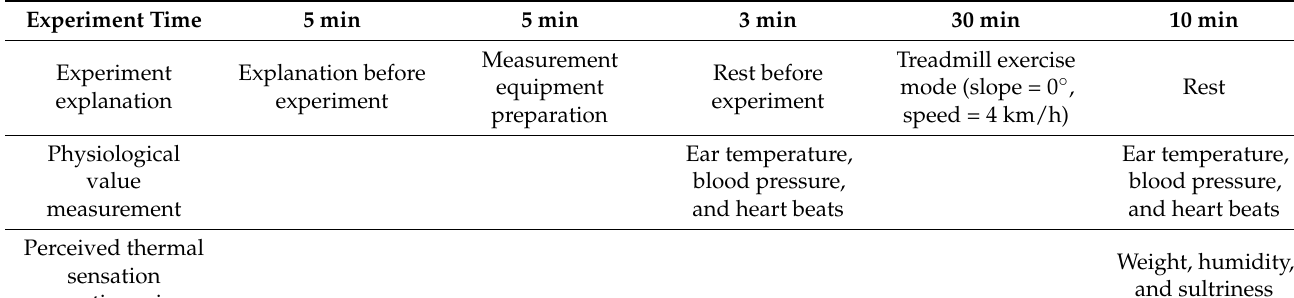
Table 4. Treadmill